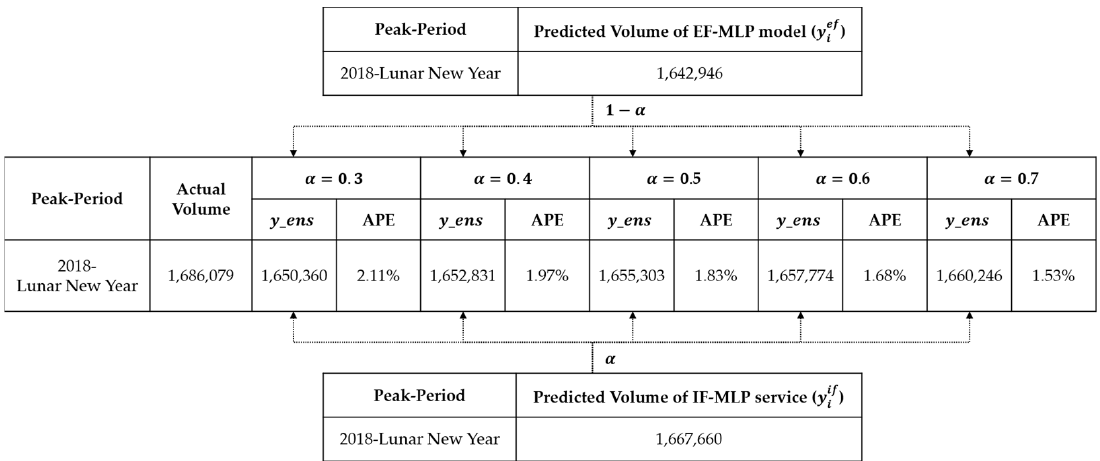
Figure 4. Example of the prediction procedure based on two MLP models; APE: Absolute Percentage Error.